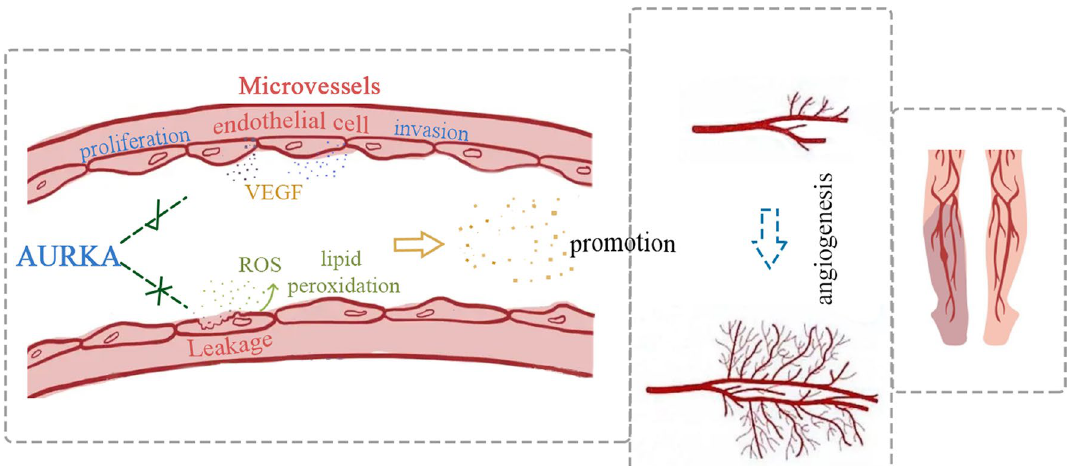
Fig. 10 A diagram illustrating the regulation mechanism of AURKA in diabetic limb ischemia. AURKA overexpression under diabetic limb ischemic condition promotes the biologic role in angiogenic endothelial cell behavior and obstructed oxidative stress to boost